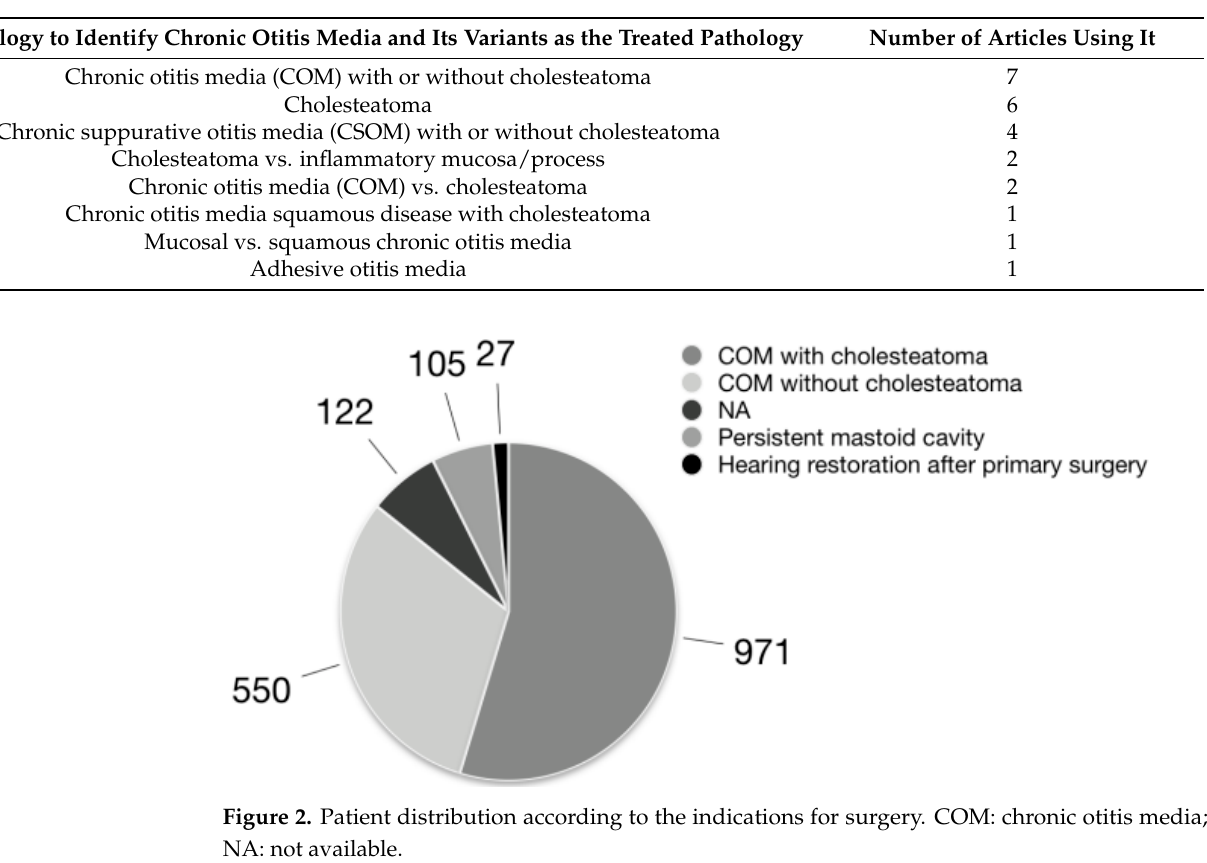
Table 1. Variability of the terminology used in the included articles to refer to chronic otitis media with and without cholesteatoma.